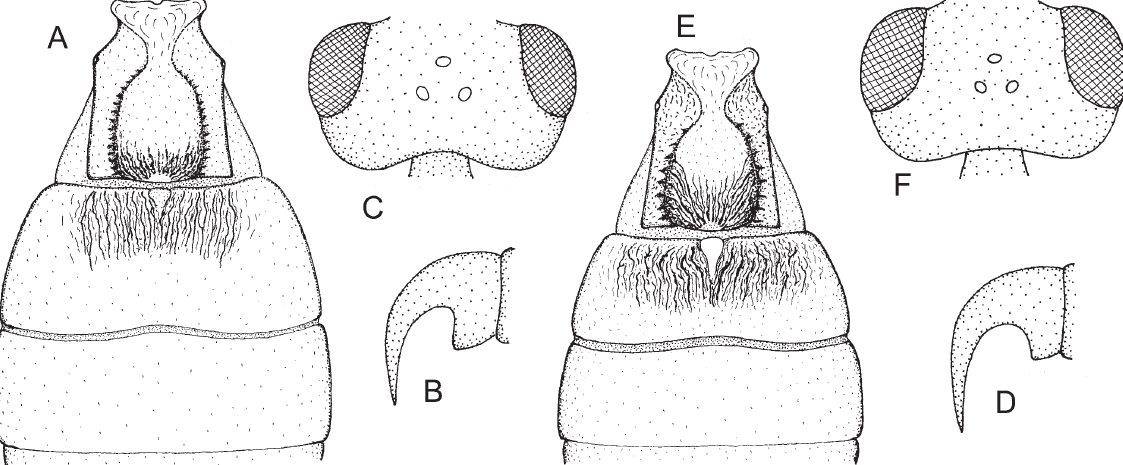
Fig. 39. — A-C . Bracon ( Glabrobracon ) subsinuatus Szépligeti, 1901, ♀ lectotype. A . Tergites 1-3. B . Claw. C . Head in dorsal view. — D-F . Bracon ( Glabrobracon ) epitriptus Marshall, 1885,